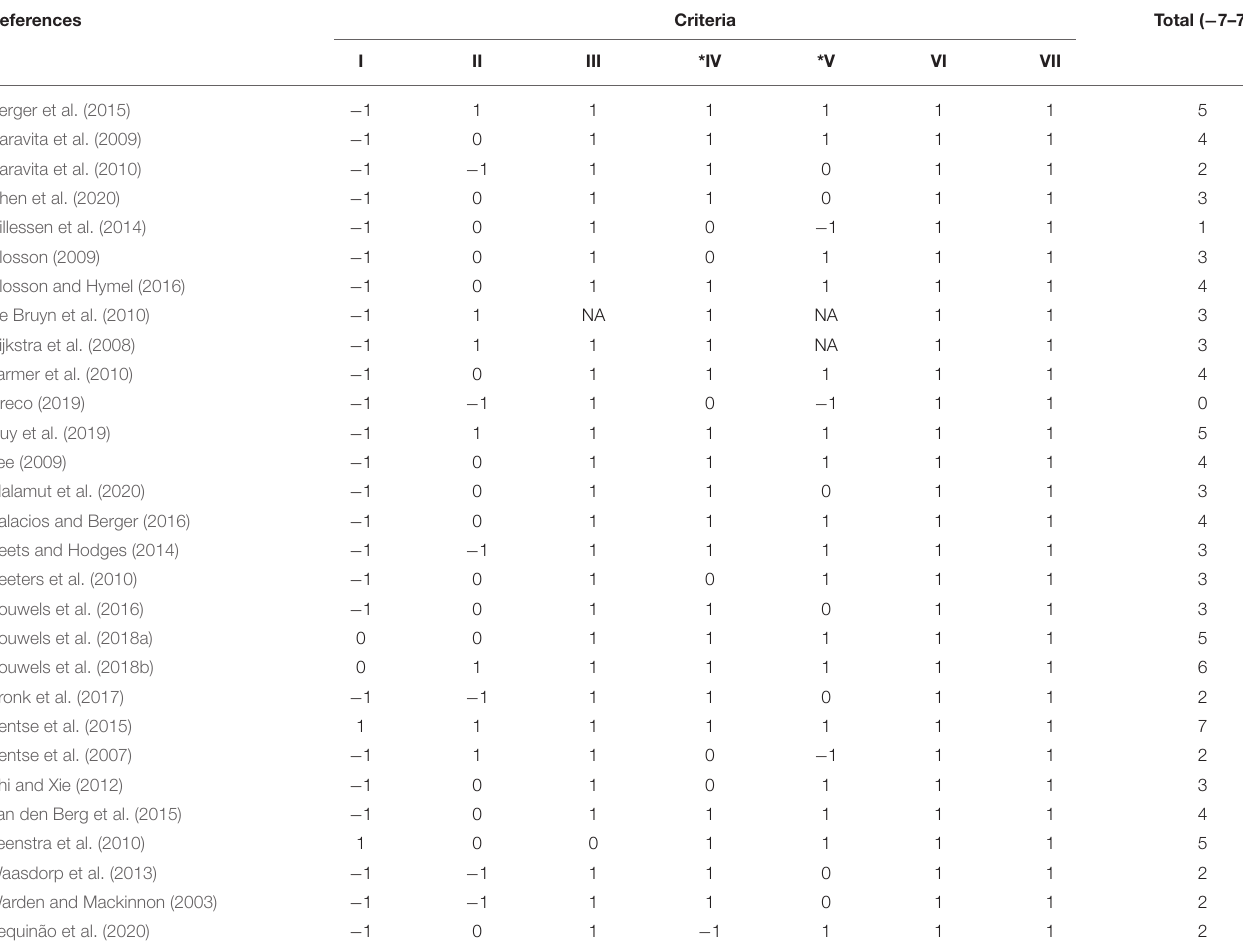
TABLE 1 | Methodological quality of